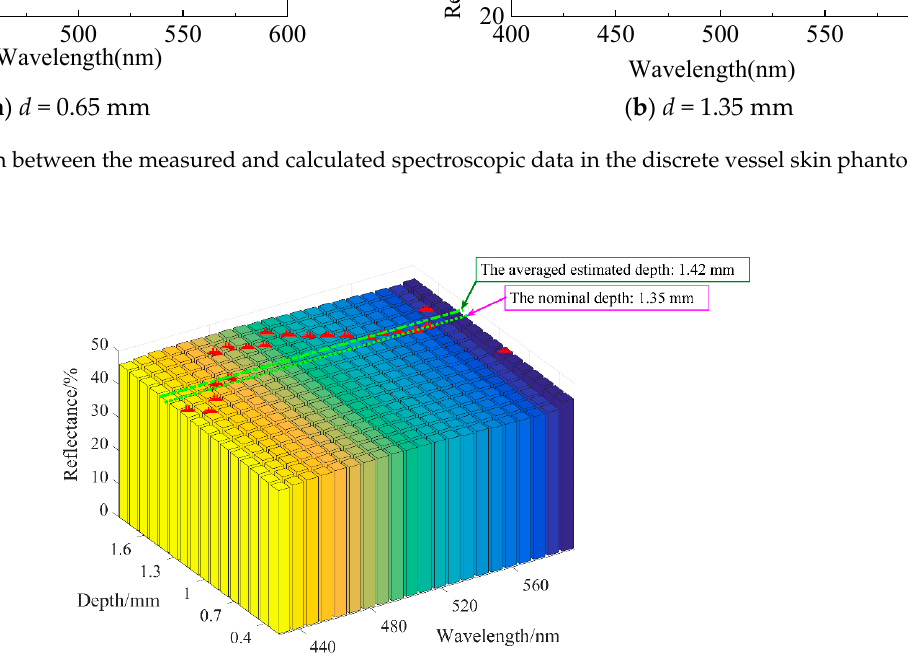
Figure 16. Extraction of vessel depth within the discrete vessel skin phantom and correspondence between blood vessel depth and reflectance spectrum.